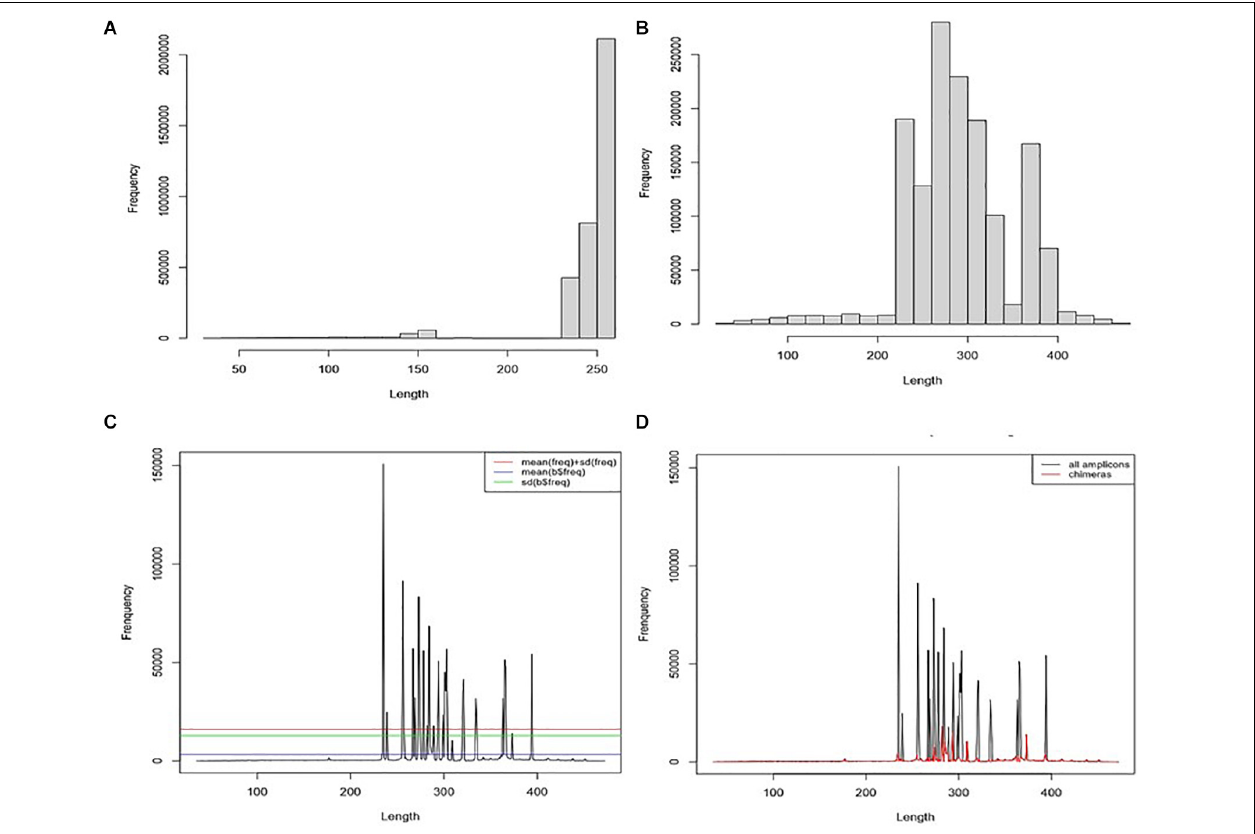
FIGURE 3 | Chimaera detection flow using ABAA : (A) distribution of reads from all datasets; The average read length is 200.9 bp ( SD = 65.6, a median of 250), the maximum reads size is 251 bp, and the minimum is 35 bp. (B) Distribution of the frequency of contigs length (assembly of forward and reverse reads), the average size is 233.3 bp ( SD = 94.45) with a maximum of 472 bp and a minimum of 35 bp. The predominant amplicons size is 251 bps. (C) Distribution of contigs length-frequency by length: determination of non-specific amplicons filtering cut-off: cut-off was tested for means (blue line), standard deviation (green line), and mean + standard deviation (red line). The standard deviation was kept for better performance. (D) Distribution of sequences by the length in all datasets. Blackline represents the distribution of all sequences). Moreover, the red line represents the distribution of filtered sequences with ABAA (standard